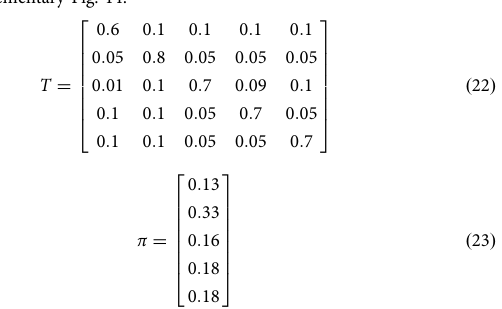
experimental lineage data, and Fig. 7c and 10 use the MCF10A lineage data. The cell lines used in this study (AU565, MCF10A) can be made available upon